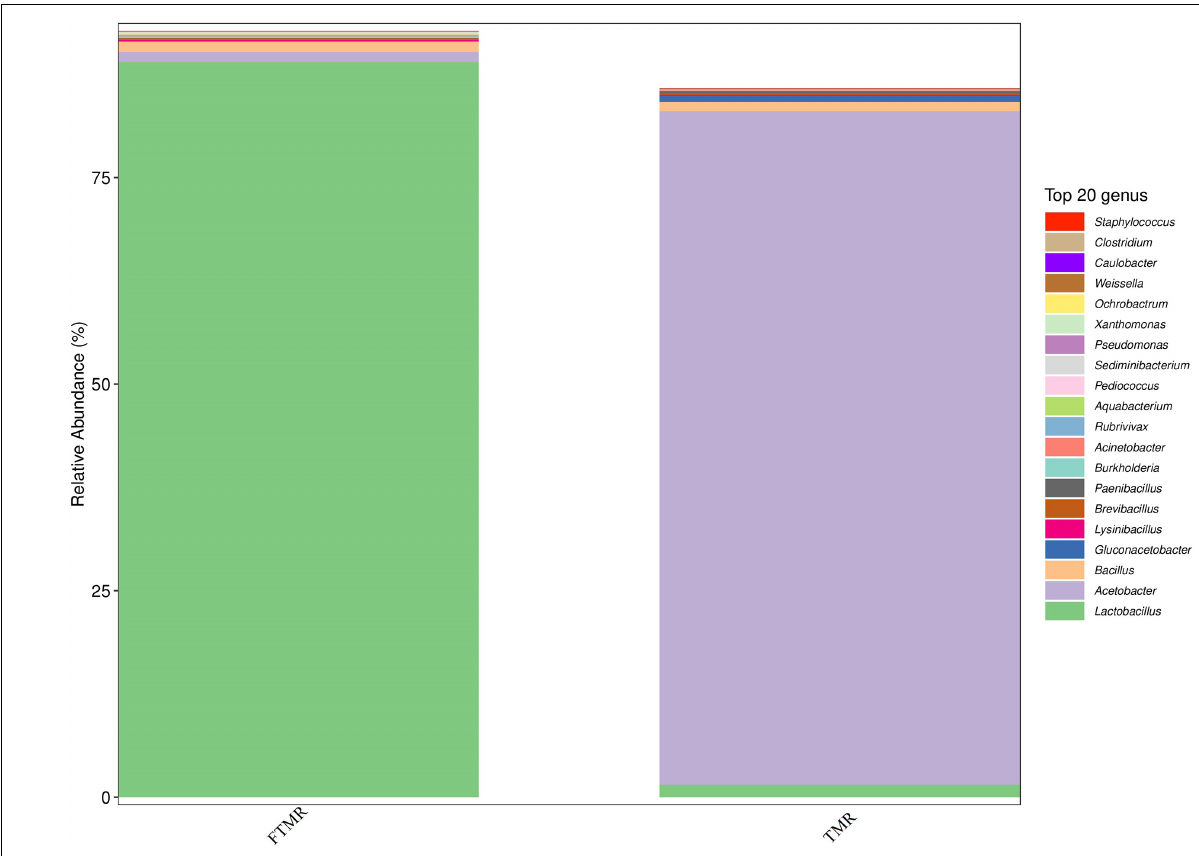
Frontiers in Microbiology |